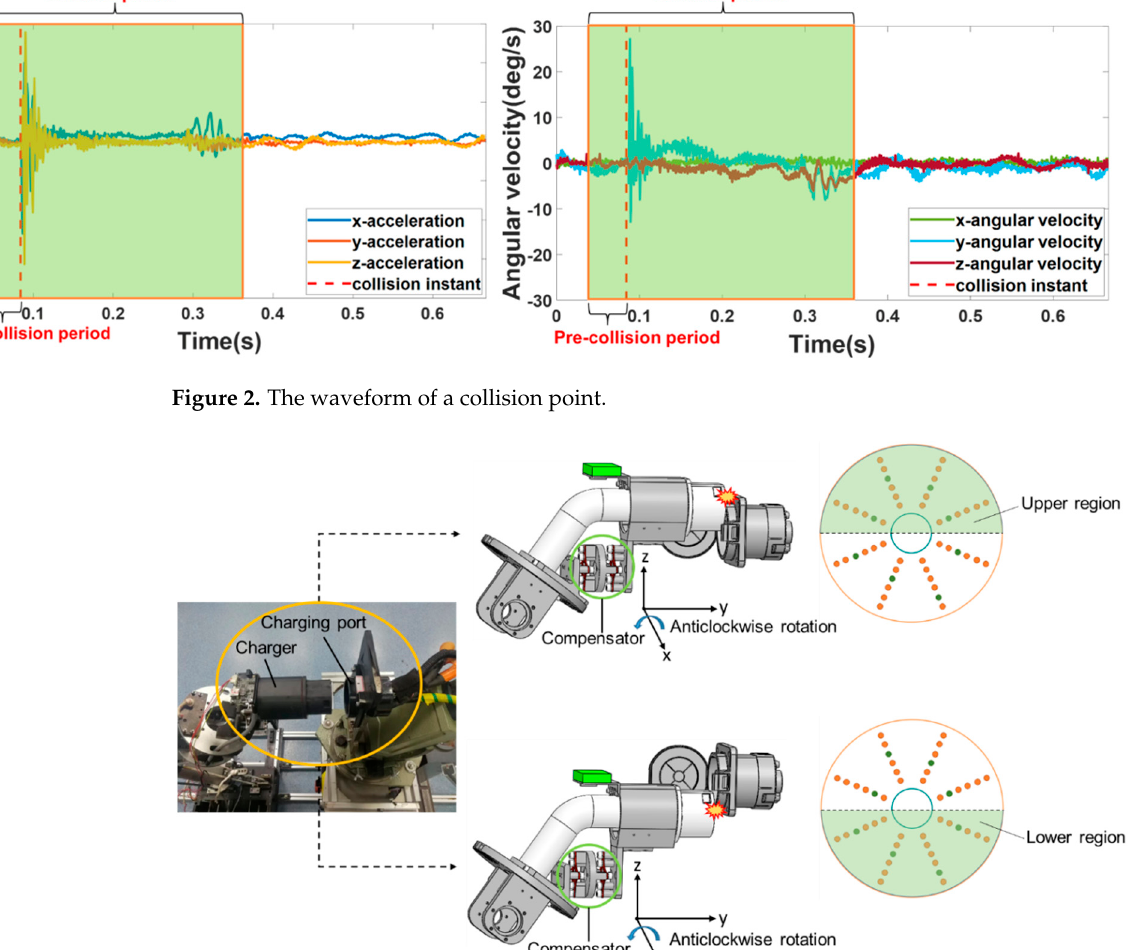
Figure 3. The collision process between the charger and the charging port.